Question: What style of plot is this figure drawn as?
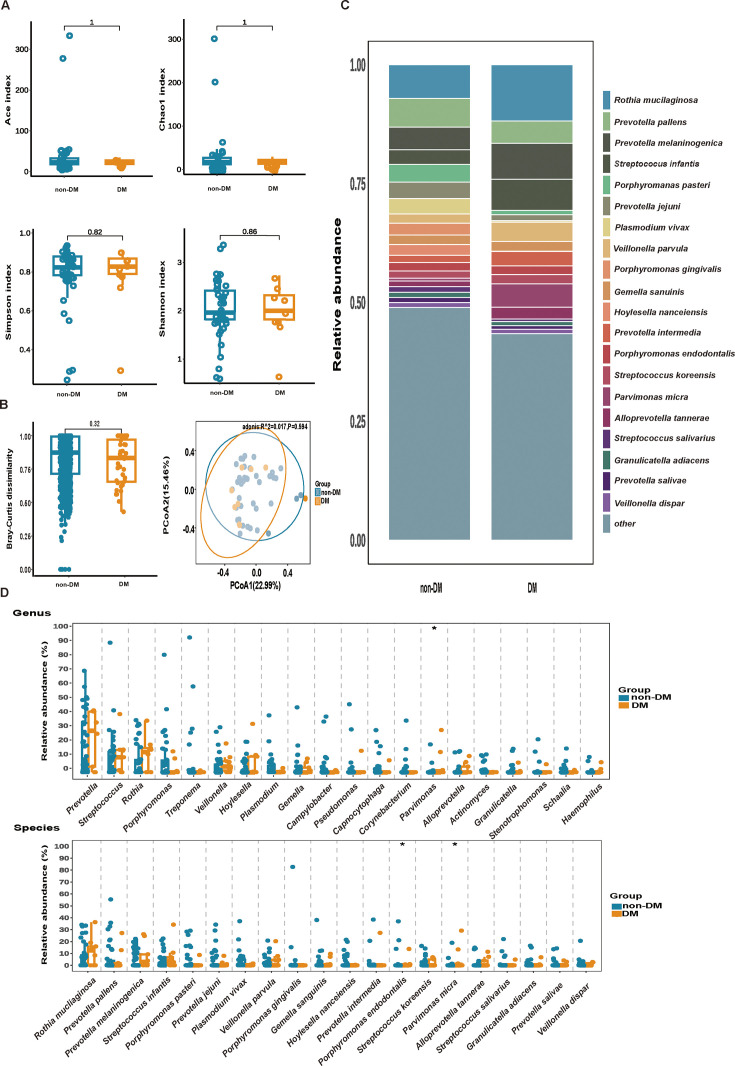
Answer: histogram